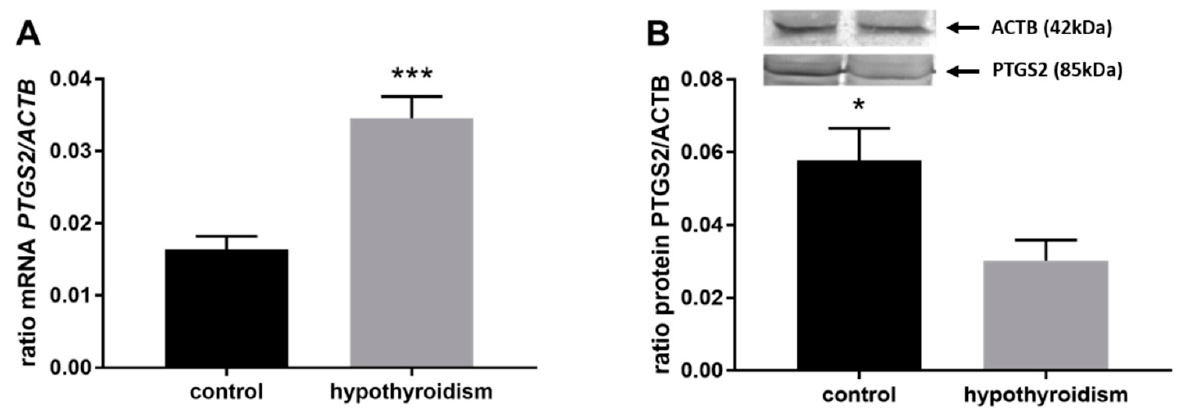
Figure 4. The effect of hypothyroidism on the mRNA ( A ) and protein ( B ) abundance of prostaglandin-endoperoxide synthase 2 in the uterine tissue of rats. The values are presented in arbitrary units and expressed as the mean ± SEM. Stars indicate significant differences (* p ≤ 0.05, ** p ≤ 0.01, *** p ≤ 0.001, **** p ≤ 0.0001), as determined by Student’s t -test.